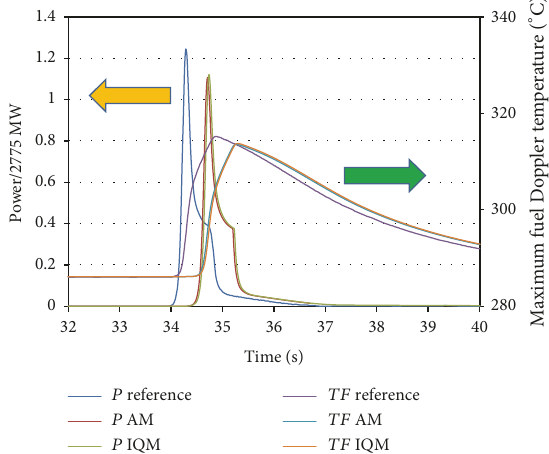
Figure 4: Fission power ( 𝑃 ) and average core Doppler temperature ( 𝑇 𝐹 ) distributions for Case B.